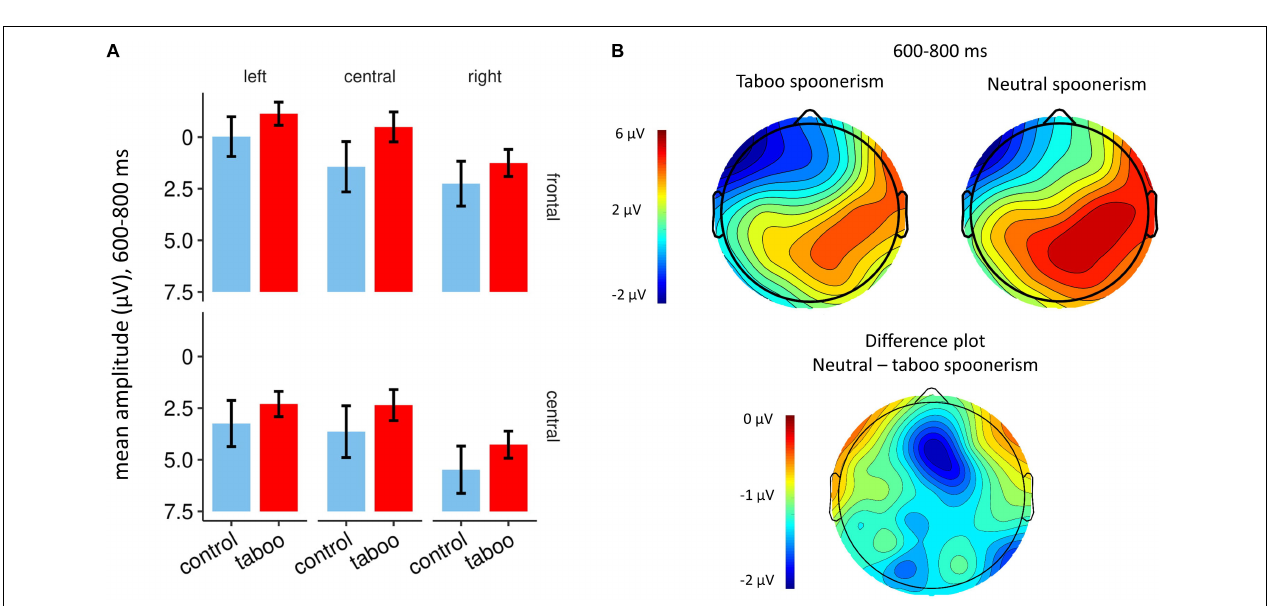
FIGURE 2 | Stimulus-locked grand average ERP waveforms at frontocentral electrodes after the presentation of the target word pair. The broad negative component is more pronounced when a taboo word spoonerism is suppressed, indicative of a pronounced conflict resolution process in this condition. Baseline used is -100 to 0 ms. The displayed waveforms were filtered with a 20 Hz low-pass